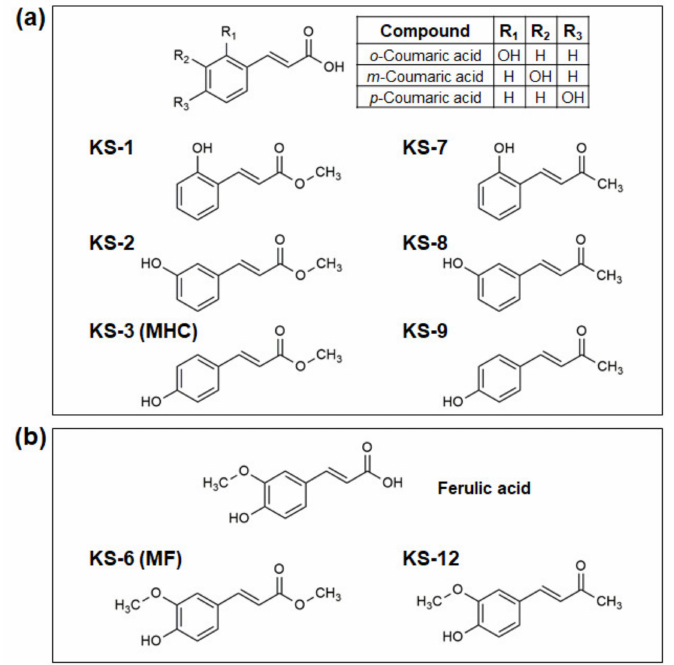
Figure 1. Molecular structures of coumaric and ferulic acids and their derivatives. ( a ) Ortho, meta and para coumaric acids and their derivatives methyl 2-hydroxycinnamate (KS-1), methyl 3-hydroxycinnamate (KS-2), methyl 4-hydroxycinnamate (KS-3), 2-hydroxybenzalacetone (KS-7), 3-hydroxybenzalacetone (KS-8) and 4-hydroxybenzalacetone (KS-9). ( b ) Ferulic acid and its deriva- tives methyl ferulate (KS-6) and 4-hydroxy-3-methoxybenzalacetone